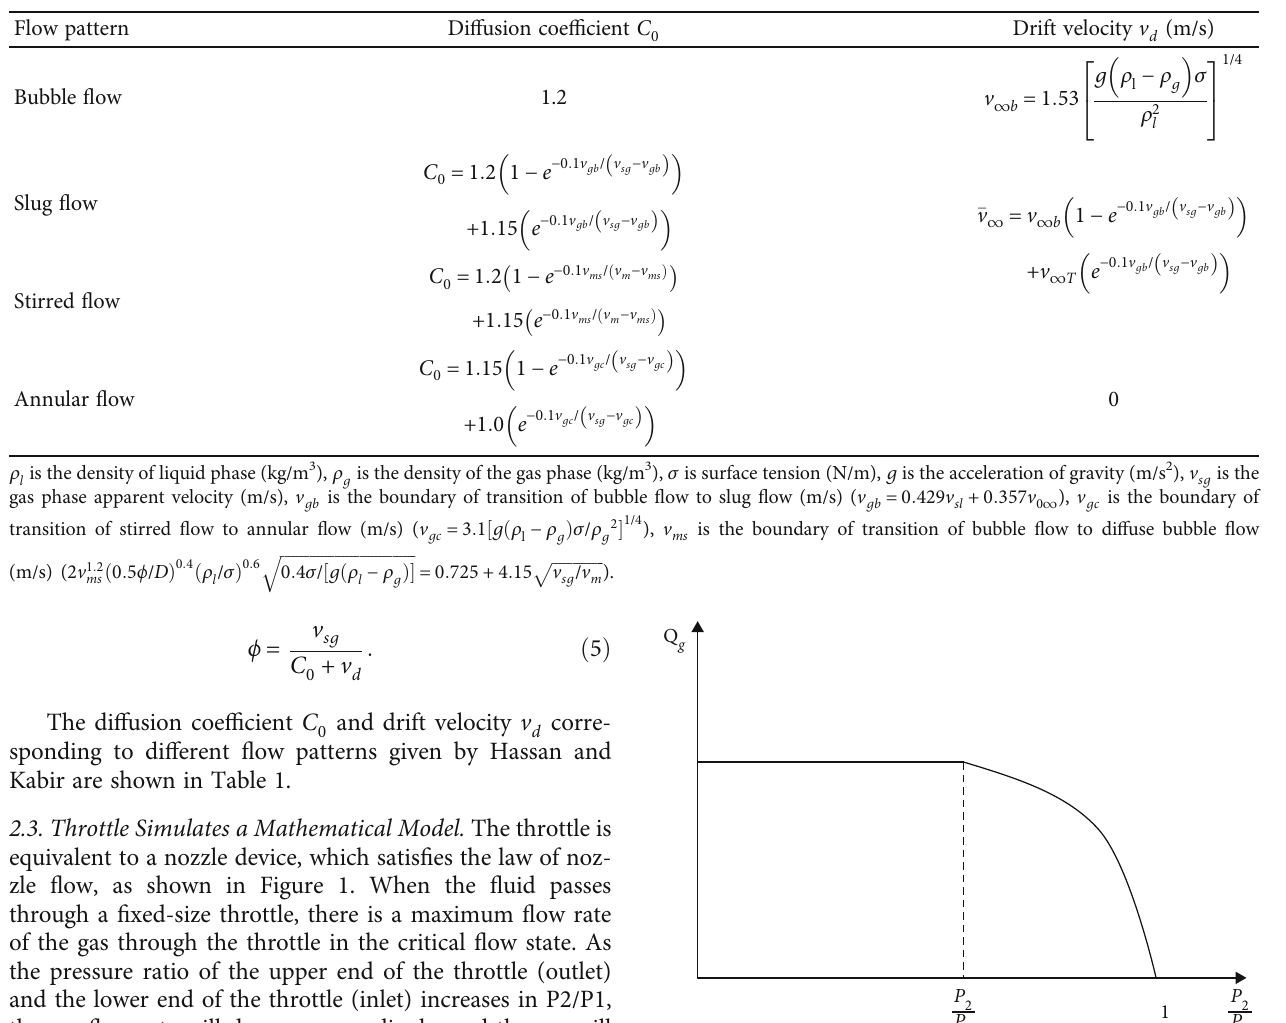
and v for di ff erent fl ow pattern. 0 d